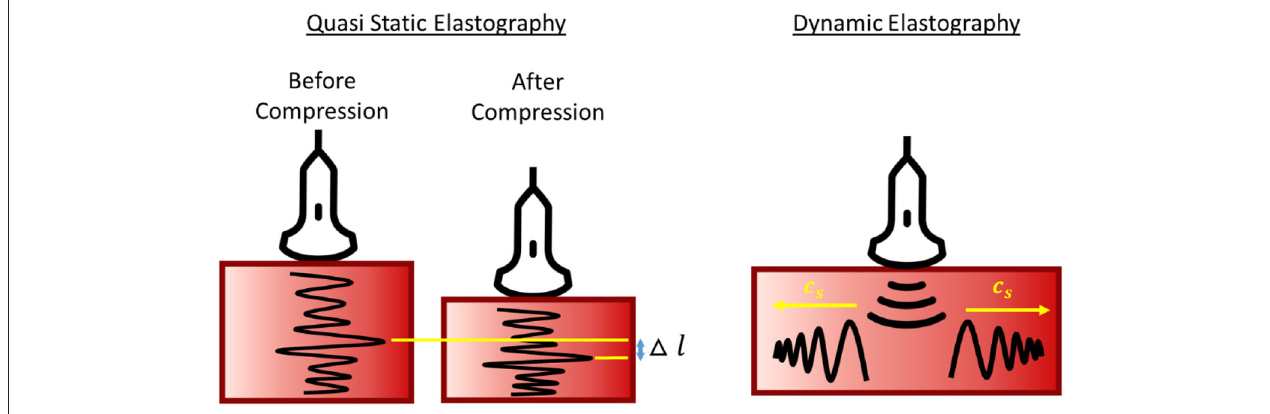
FIGURE 5 | Schematic diagram of quasi-static and dynamics elastography. Stiffness is represented by tissue deformation and propagation wave speed in quasi-static and dynamic elastography,